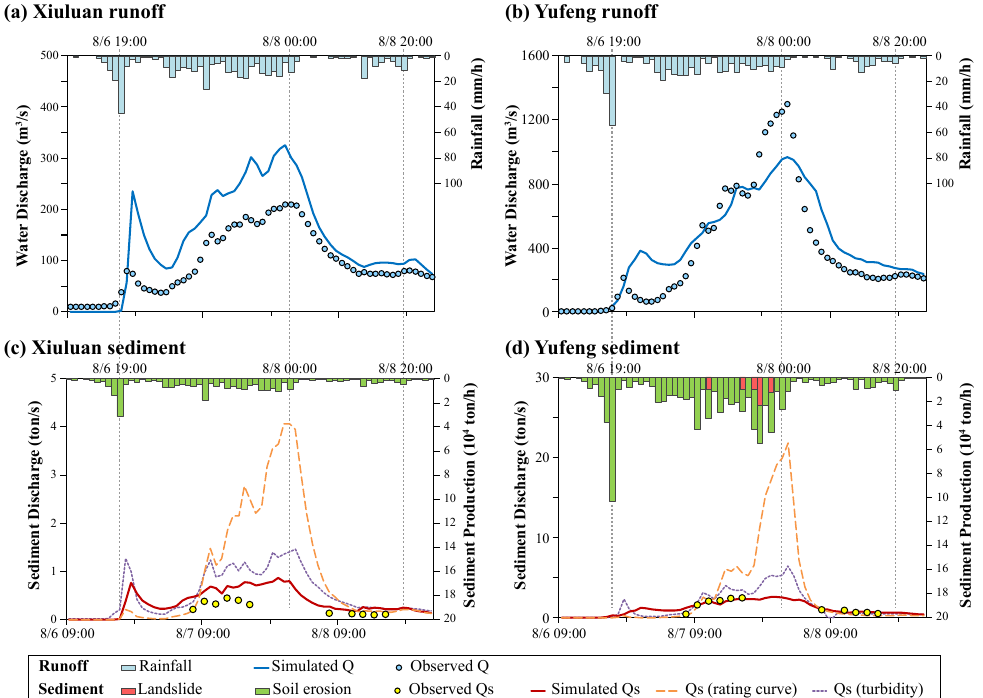
Figure 8. Hydrograph of simulated runoff and sediment discharge at Xiuluan (left column) and Yufeng (right column) gauge stations during Typhoon Morakot. The spatial distributions at the time marked by the three dashed are illustrated in Figure 6. ( a ) Xiuluan runoff; ( b ) Yufeng runoff; ( c ) Xiuluan sediment; ( d ) Yufeng